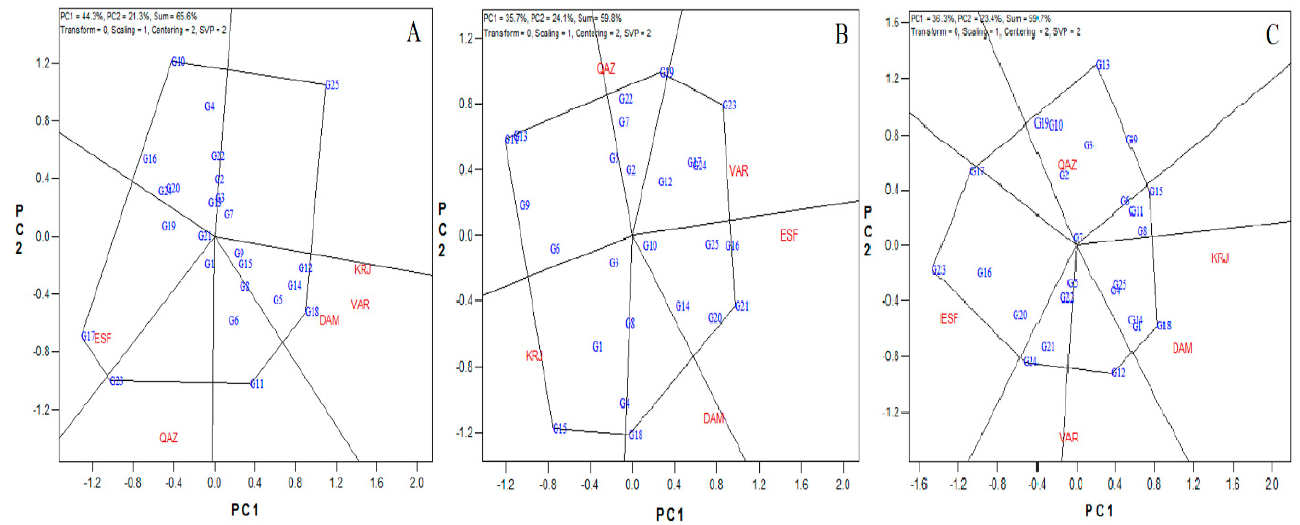
Figure 3. Polygon views of the GGE biplot based on symmetrical scaling for the which-won-where pattern of genotypes and environments. ( A ): First year, ( B ): Second year, ( C ): Average of two years.